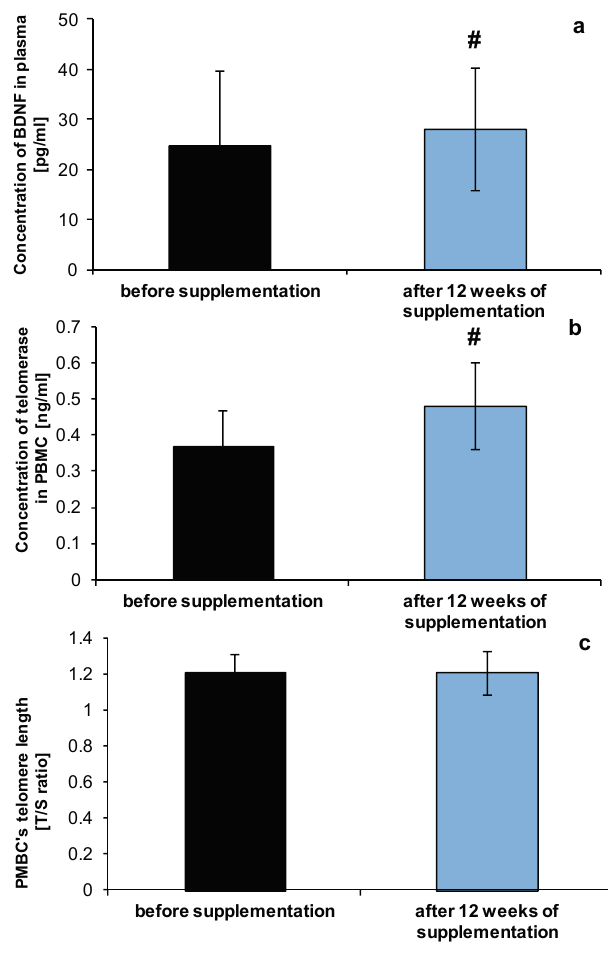
Figure 4. Level of BDNF ( a ), telomerase activity ( b ) and PMBC’s teleomere length ( c ) of healthy volunteers before and after NucleVital ® Q10 Complex supplementation. # indicates statistically significant differences ( p <